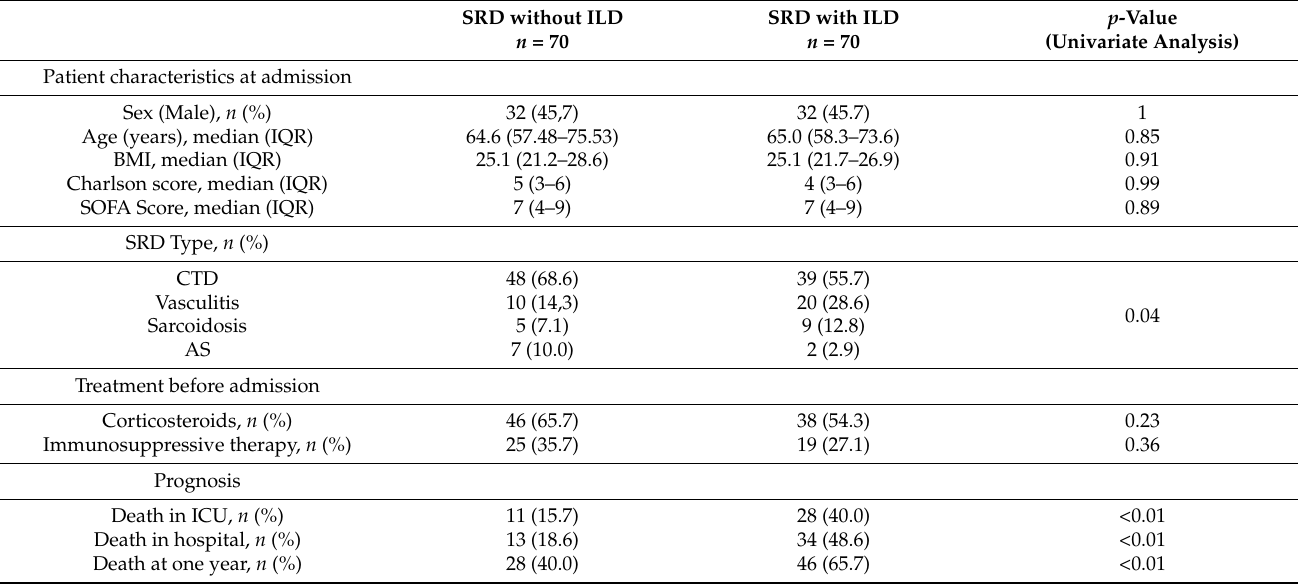
Table 3. Comparison to the control group (SRD patients without ILD).